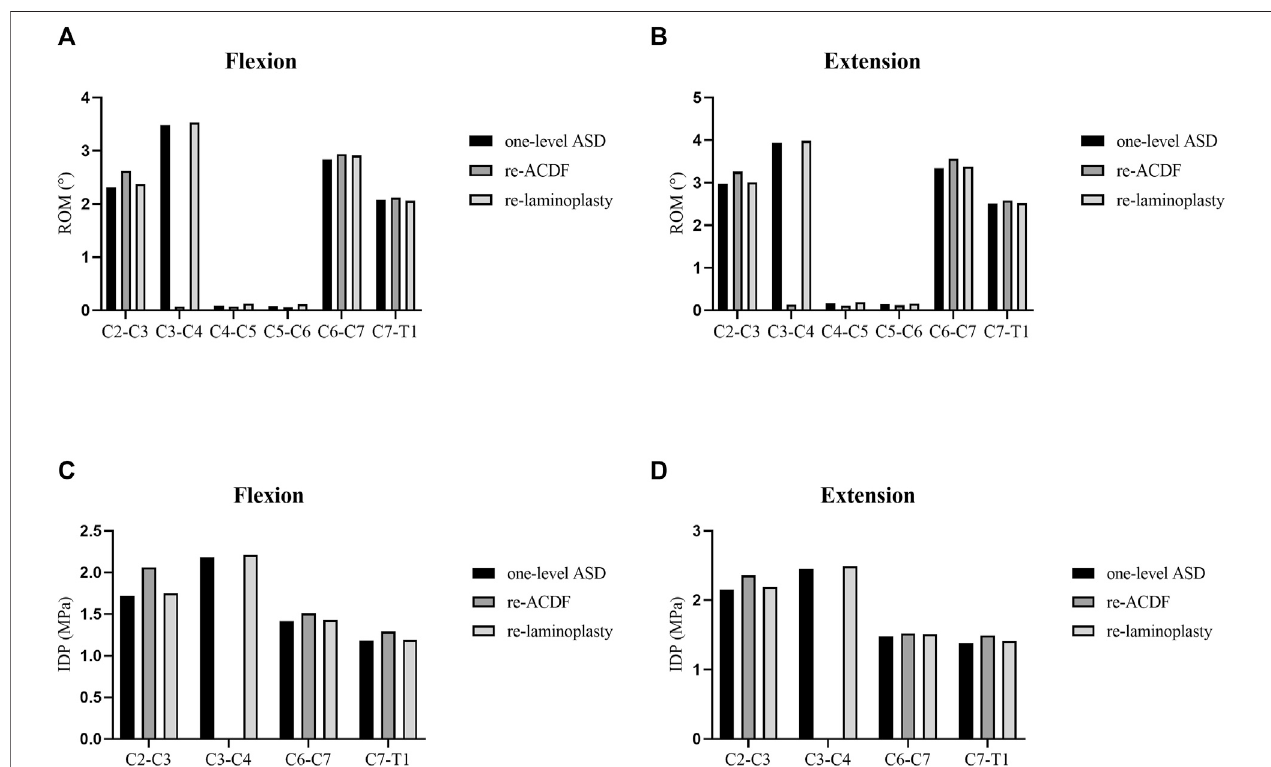
FIGURE 5 | ROM and IDP of different revision surgeries for the treatment of one-level ASD. (A) ROM in fl exion. (B) ROM in extension. (C) IDP in fl exion. (D) IDP in extension.